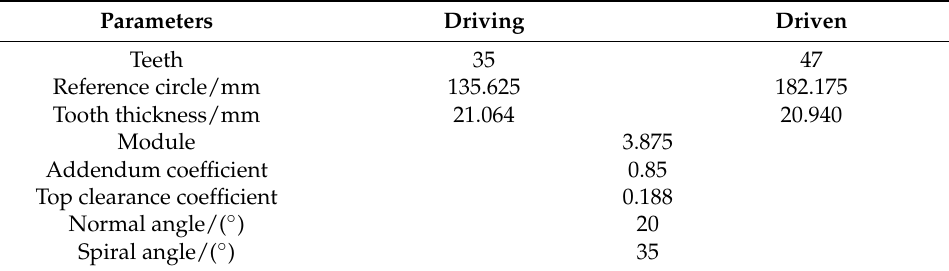
Table 2. Geometric parameters of gears.